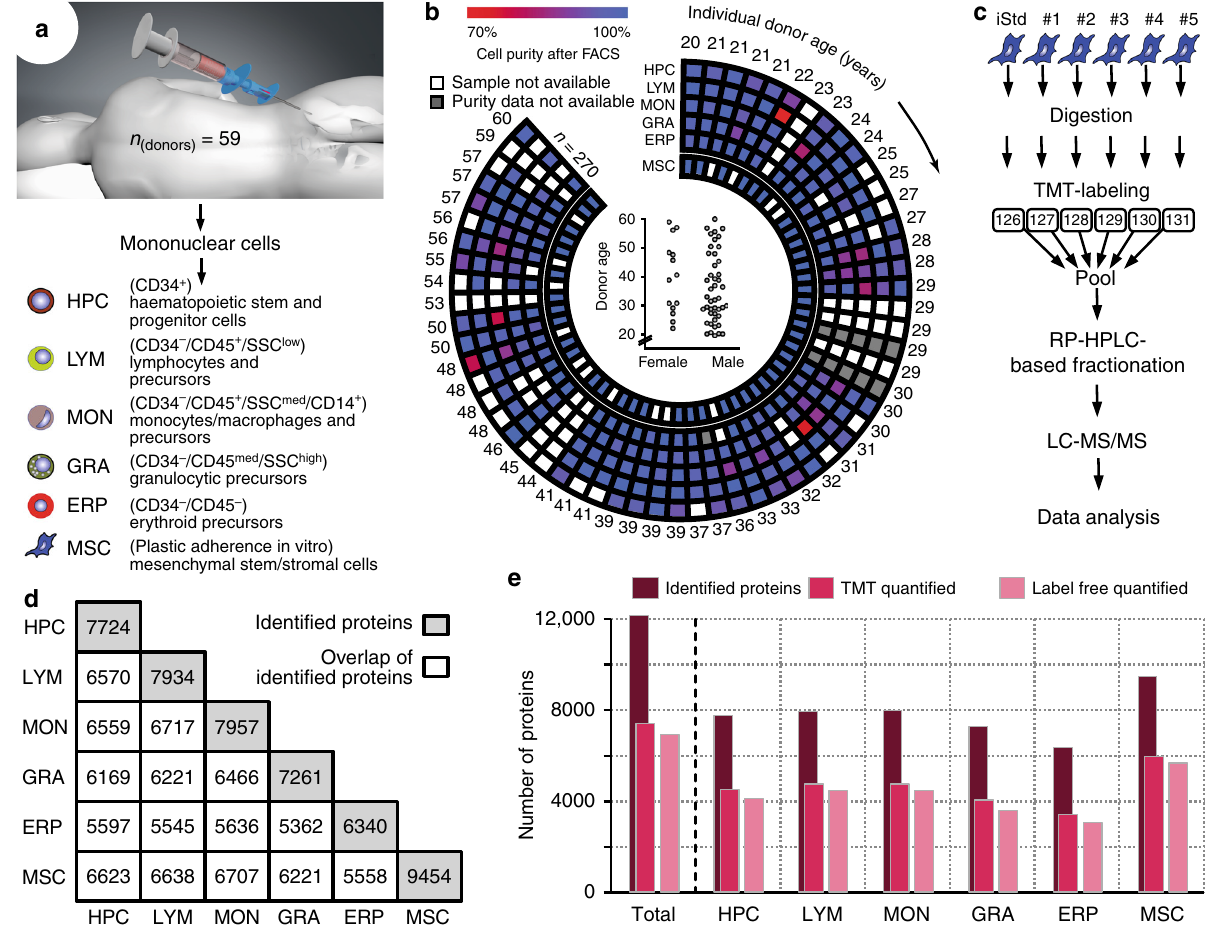
Fig. 1 Summary of the experimental design of the proteomics study and description of the dataset. a Bone marrow samples were aspirated from human subjects and mononuclear cells were separated by FICOLL gradient centrifugation. Haematopoietic stem and progenitor cells (HPCs), lymphocytes and precursors (LYMs), monocytes/macrophages and precursors (MONs), granulocytic (GRAs), and erythroid precursors (ERPs) were isolated by fl uorescence-activated cell sorting (FACS). Mesenchymal stem/stromal cells (MSCs) were expanded in cell culture. b The purity of the 270 samples derived from the 59 eligible human subjects is visualized by a colour gradient ranging from 70% (red) to 100% (blue). Each circle represents one cell type. The age of each of the individual donors is indicated at the periphery of the circle. The graph inside the circle depicts the age distribution of the 59 subjects separated by gender. c The different cell populations were processed separately for proteomics analysis. The samples of the same cell population from fi ve human subjects, together with a cell type-speci fi c internal standard, were processed in one batch. The cells of the samples were lysed, digested, labelled with the tandem mass tag (TMT), and subsequently pooled. This pool was separated by reversed phase HPLC and fractionated. The fractions were analysed by LC-MS/MS followed by bioinformatics analysis. d This graphic shows the pairwise overlap of the proteins identi fi ed in each cell population with the diagonal indicating the total number of proteins identi fi ed in the respective cell type. e Overview on the total number of proteins identi fi ed, quanti fi ed with TMT or by label-free quanti fi cation across all (total) as well as for the individual cell